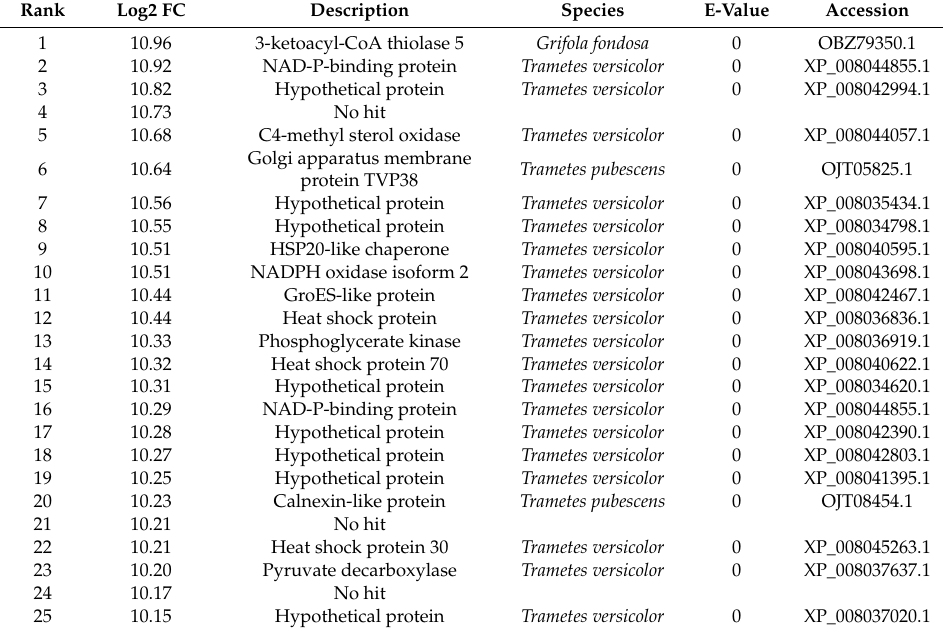
Table 3. The number of di ff erentially expressed transcripts between the di ff erent databases. Di ff erentially Expressed Set Up-Regulated Down-Regulated Transcripts BET vs. Control 3943 3863 80 Table 4. 50 up-regulated transcripts of A. sinapina in cells cultivated in the presence of betulin. Rank Log2